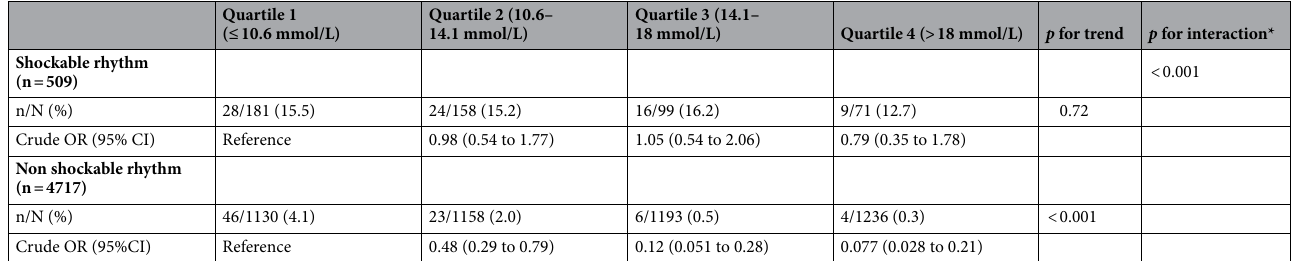
Table 3. One-month survival after OHCA by serum lactate level measured during cardiac arrest at hospital arrival according to first documented rhythm. OHCA out-of-hospital cardiac arrest, ROSC return of spontaneous circulation, OR odds ratio, CI confidence interval. * p for interaction was calculated between serum lactate level and first documented rhthm in 1-month